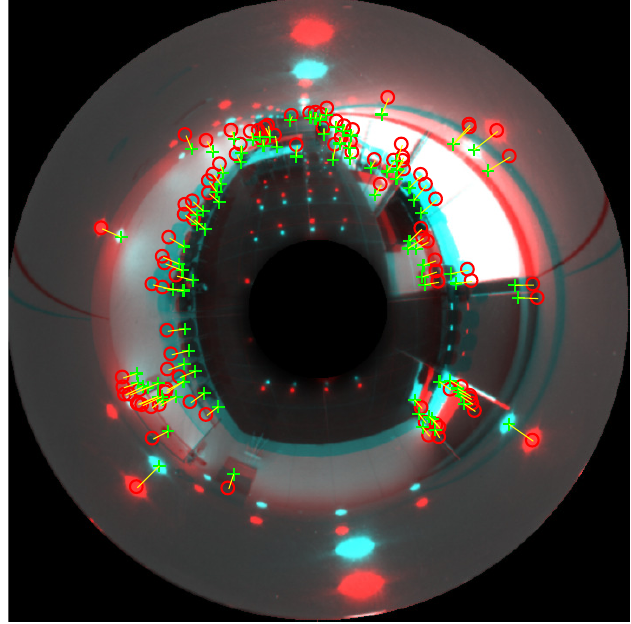
Figure 8. Final step of the alternative method. The red-colored image is the reference image, and the blue colored is the test image. The red circles are the final landmarks in the reference image (after removing outliers), and the green crosses are the valid landmarks in the test